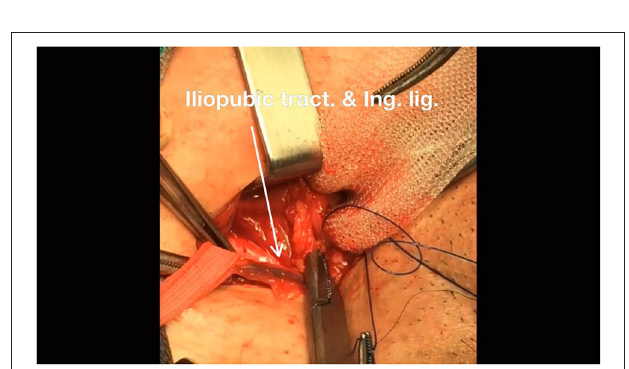
FIGURE 4 | Then, continue suturing to the external iliopubic tract or above the inguinal ligament.